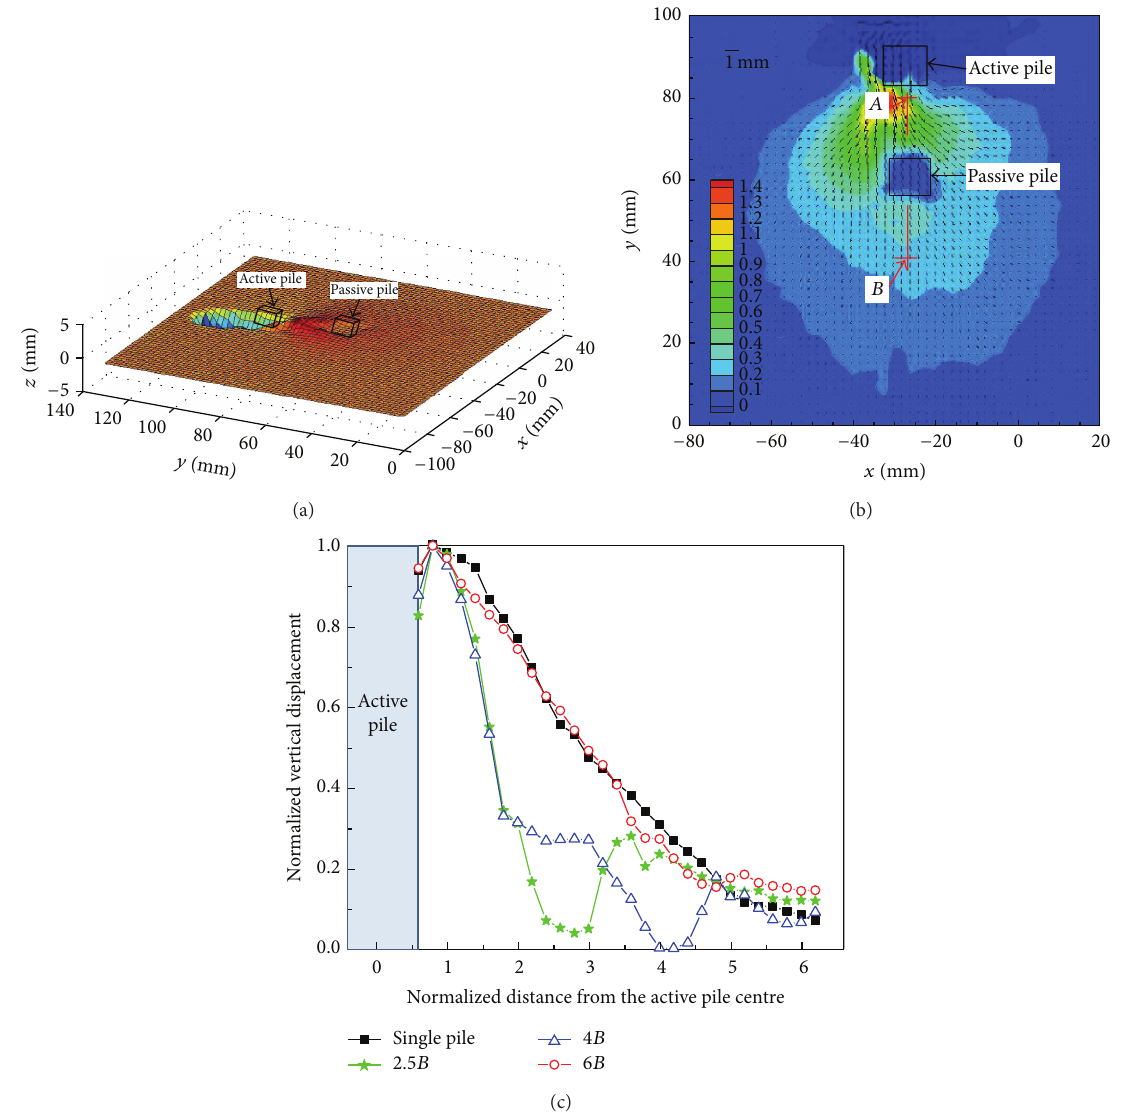
Figure 3: Vertical displacement field: (a) 3D view of vertical displacement field of 2.5 B pile spacing; (b) vertical displacement field of 2.5 B pile spacing; (c) normalized vertical displacement along the section A-B in